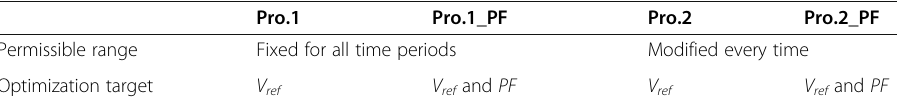
Table 4 Proposed